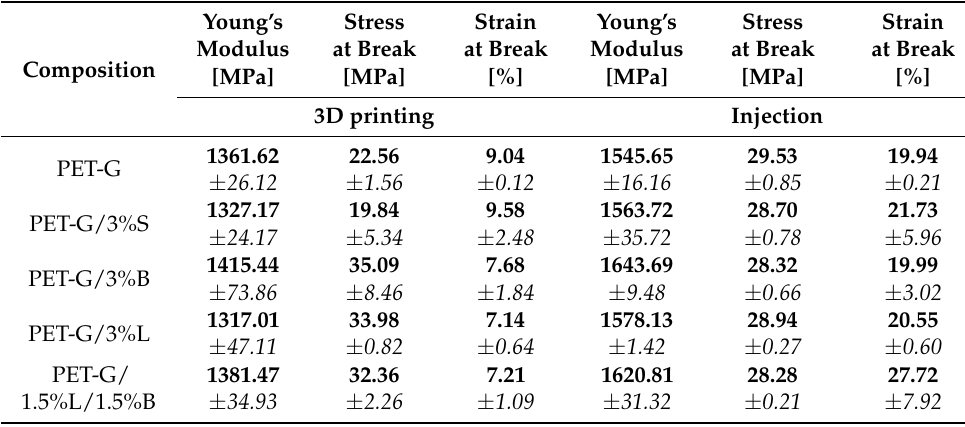
Table 4. Results of mechanical tests of PET-G and composites based on